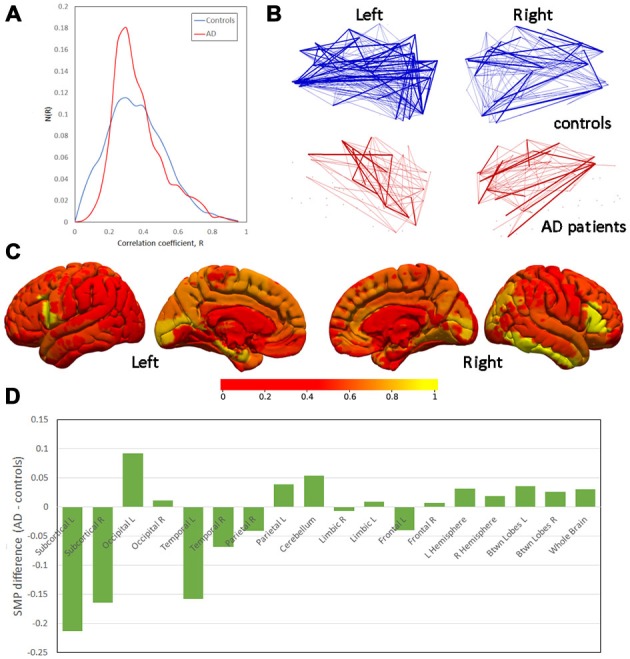
Differences in semi-metricity. (A) Histograms of correlation coefficients, R, aggregated across all participants in each group. (B) Projections of semi-metric backbones for left and right hemispheres demonstrating the lower number of consistent semi-metric edges in Alzheimer’s disease (AD) patients. (C) Between-group differences in the node-averaged semi-metric connections to all other regions (scale normalized for display). (D) Between-group differences in semi-metric percentage (SMP) ranked by the mean Euclidean distance between nodes.